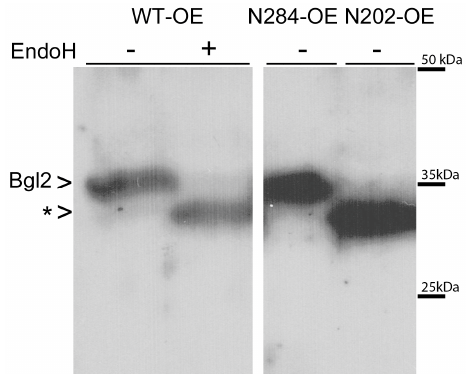
Figure 2. Western blot analysis of Saccharomyces cerevisiae cell lysates obtained from WT-OE, N202-OE, and N284-OE strains. Samples were incubated for 15 min with (+) or without ( − ) endoglycosydase H (EndoH). Bgl2 bands are denoted by arrowheads; (*) indicates unglycosylated Bgl2. Staining with antibodies against Bgl2.